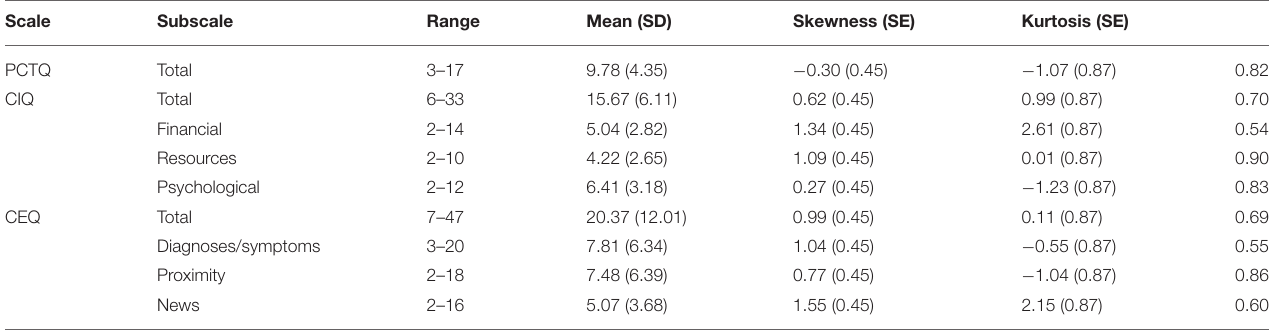
TABLE 6 | Descriptive statistics on the short CDC COVID-19 scales: PCTQ, Perceived Coronavirus Threat Questionnaire; CIQ, Coronavirus Impacts Questionnaire; CEQ, Coronavirus Experiences Questionnaire.